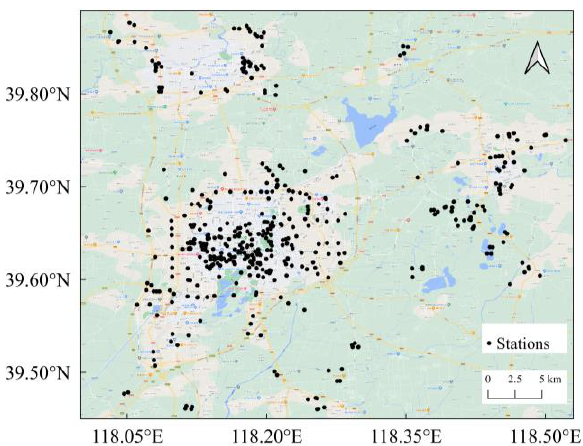
Figure 1. Distribution of air quality monitoring stations in the study area.